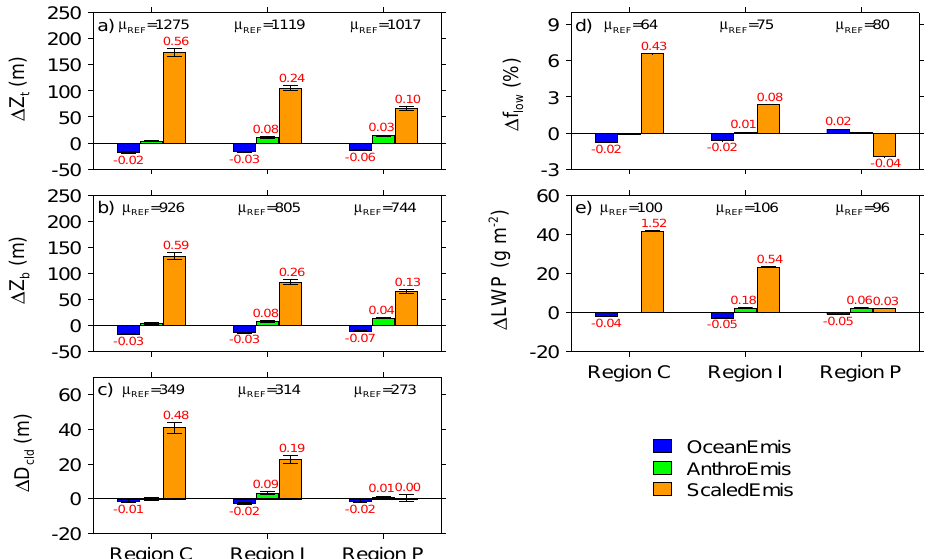
Fig. 4. Same as in Fig. 2 but for responses of mean cloud top height ( Z t , panel a ), cloud base height ( Z b , panel b ), cloud depth ( D cld , panel c ), low cloud fraction ( f low , panel d ), and liquid water path (LWP, panel e ) to regional oceanic (OceanEmis, blue), anthropogenic (AnthroEmis, green), and scaled anthropogenic (ScaledEmis, orange)